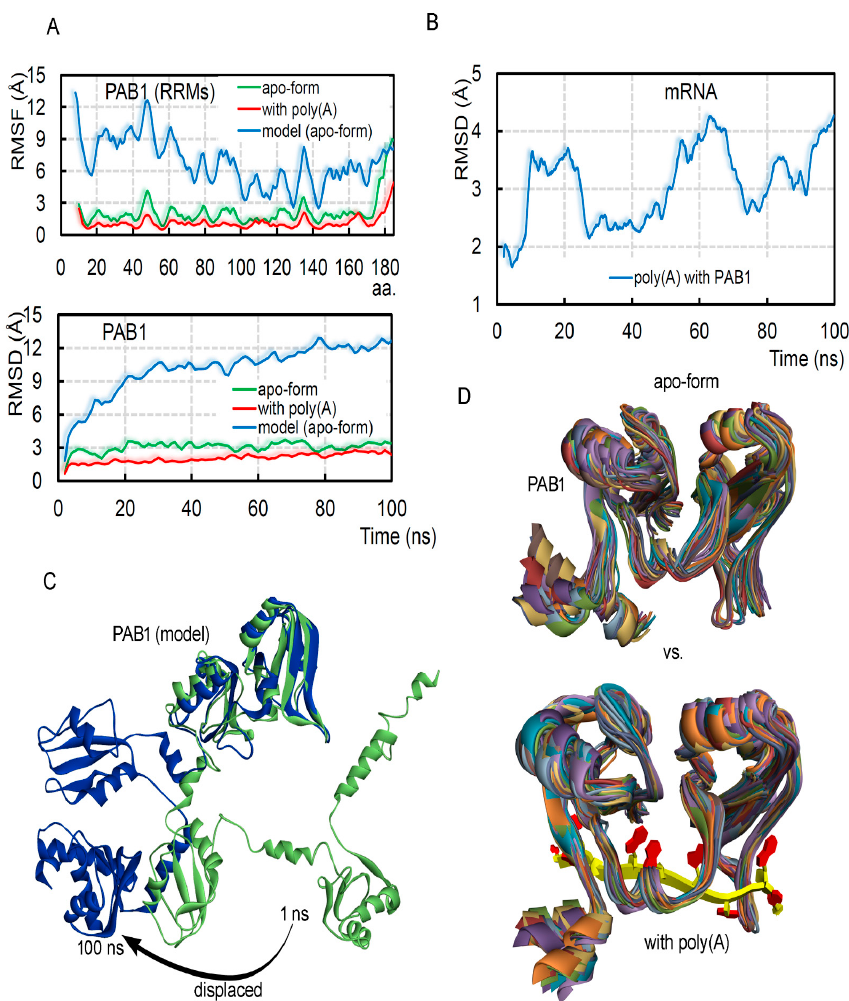
Figure 2. Dynamics of the PABPC1 or PAB1 protein, influenced by the presence of poly(A) mRNA. ( A ) RMSFs (root-mean-square fluctuation) of individual amino acids of RRM1–2 domains from PAB1 in different conditions, as well as the RMSDs (root-mean-square deviation, excluding hydrogen atoms) of the PAB1 structure. ( B ) The RMSDs for the poly(A) mRNA motif (5- (cid:48) AAAAAAAAA-3 (cid:48) ) in the system with the PAB1 protein. ( C ) The conformational dynamics or the folding of the modeled PABPC1 structure (RRM1–4) observed during 100 ns MD simulations, superimposed with the simulated crystal structure (RRM1–2). ( D ) The protein coordinates retrieved from different time frames of the MD simulations for the RRM1–2 domains from PAB1 complexed with poly(A) mRNA or apo-form. The intermolecular interactions between poly(A) mRNA-PABPC1 suggest that ~8 H-bonds were formed every nanosecond (ns), and the PAB1 amino acids were found to be distributed over the mRNA (Figure 4A). The PAB1 residues D45, Y54, Y56, N58, Q88, and N100 formed long-lasting interactions having an occupancy ≥ 40% with the mRNA (Figure 4B). In particular, the poly(A) mRNA showed a unique pattern in the presence of PAB1. Every second nucleotide from both 5 (cid:48) and 3 (cid:48) ends was in an “inward-position” facing towards PAB1, whereas every third nucleotide had an “outward-position” conformation. The centered three nucleotides were found facing towards the region between RRM1–2 domains of the PABPC1 protein (Figure 2A,B). Specifically, aromatic amino acids from the PABPC1 protein (Y14, Y54, Y56, W86, and Y140) were found binding with poly(A) mRNA. These findings correlate with previously reported R94 and R179 residues involved in hydrogen bond interaction with the mRNA